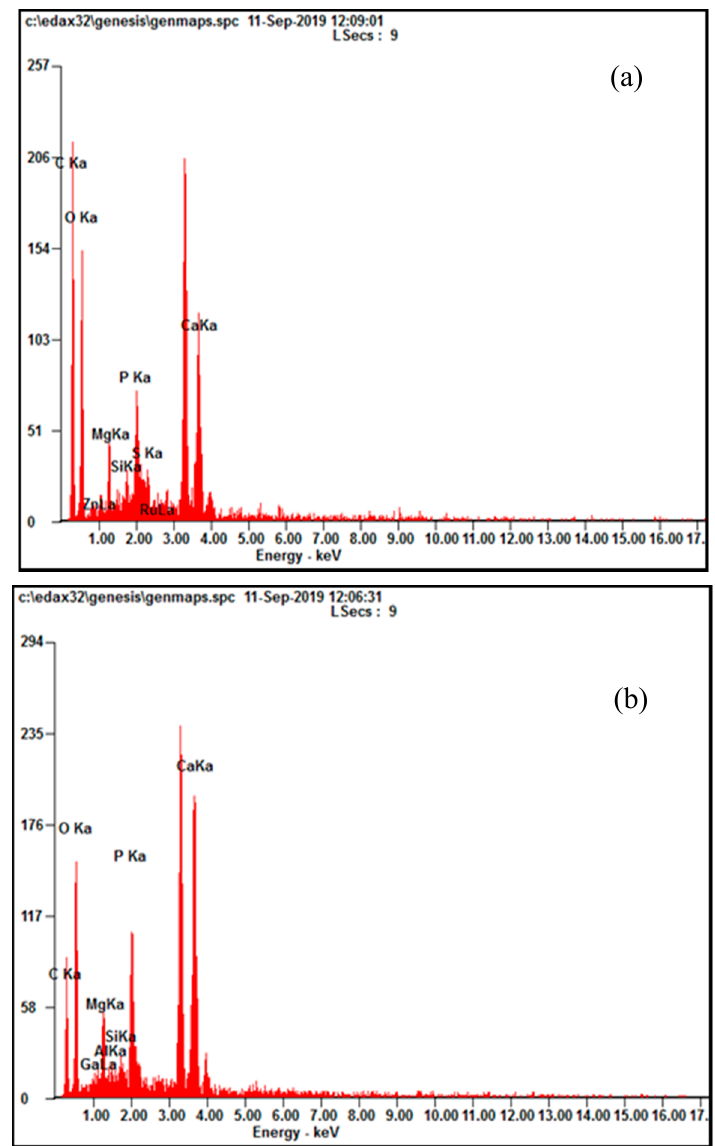
Figure 8. Elemental composition change of ( a ) original BioAsh and ( b ) BioAsh after being wet-dried.